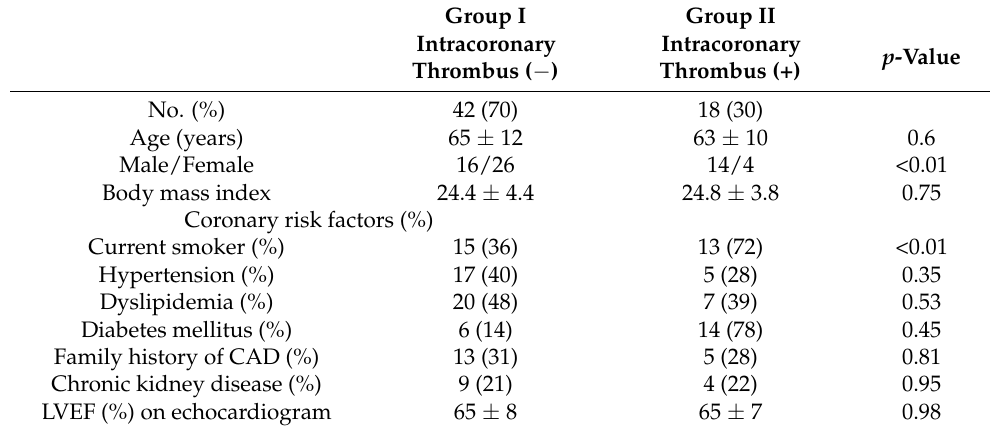
Table 1. Patients’